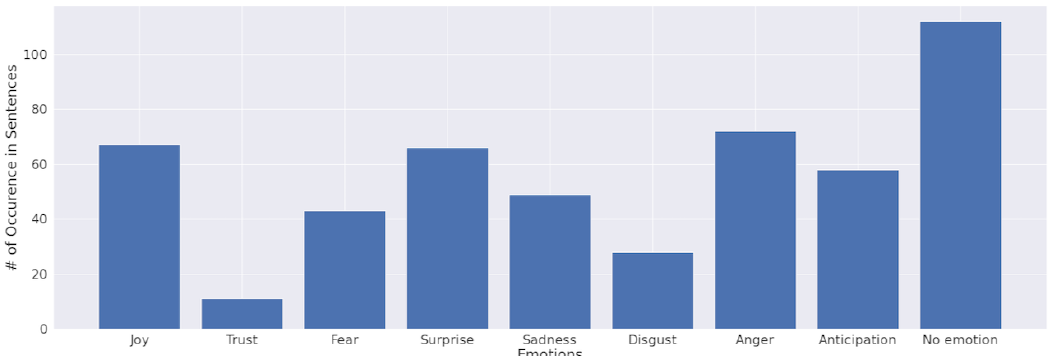
Figure 5. Number of emotions in annotated dataset.